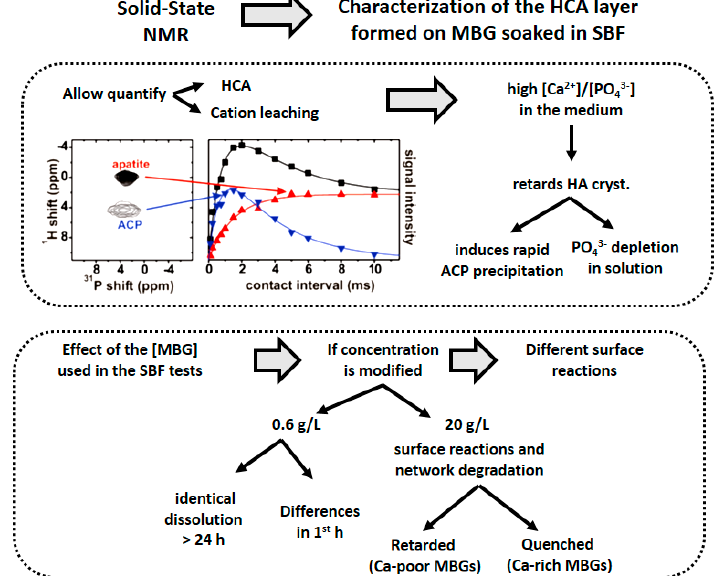
Figure 7. NMR can be used to characterize the HCA coating the bioactive MBG after being soaked in SBF. Top: The relative amount of ACP and HCA in the newly formed layer was quantified. NMR demonstrated that high Ca 2+ /PO 43 − ratios in the surrounding liquid medium retarded the HCA formation on MBG. Bottom: NMR demonstrated the effect of the MBG concentration used in the SBF tests.